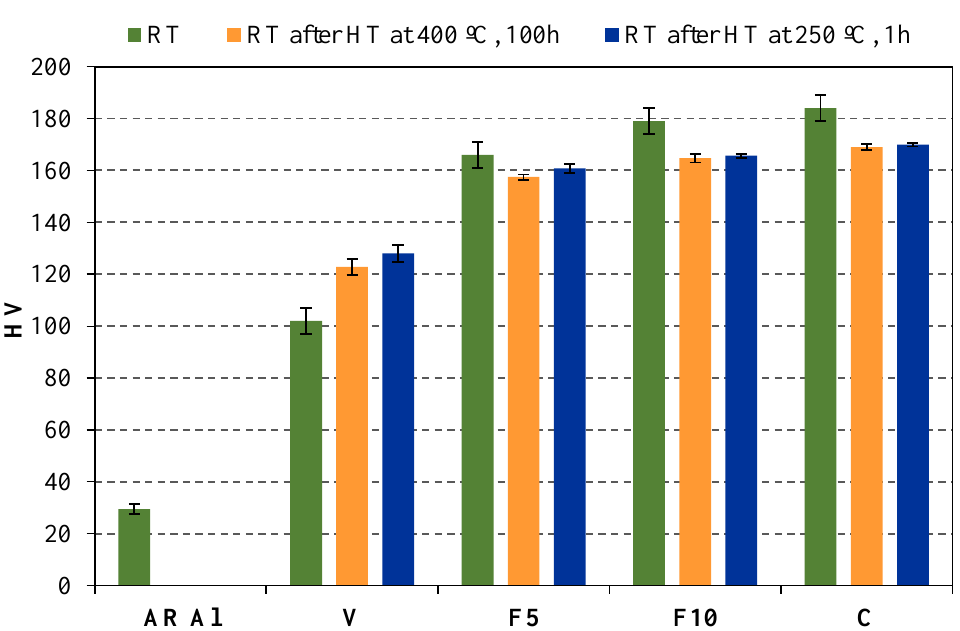
Figure 1. Vickers hardness measured at room temperature with (RT after HT at 400 °C, 100 h and RT after HT at 250 °C, 1 h) and without (RT) a previous heat treatment.